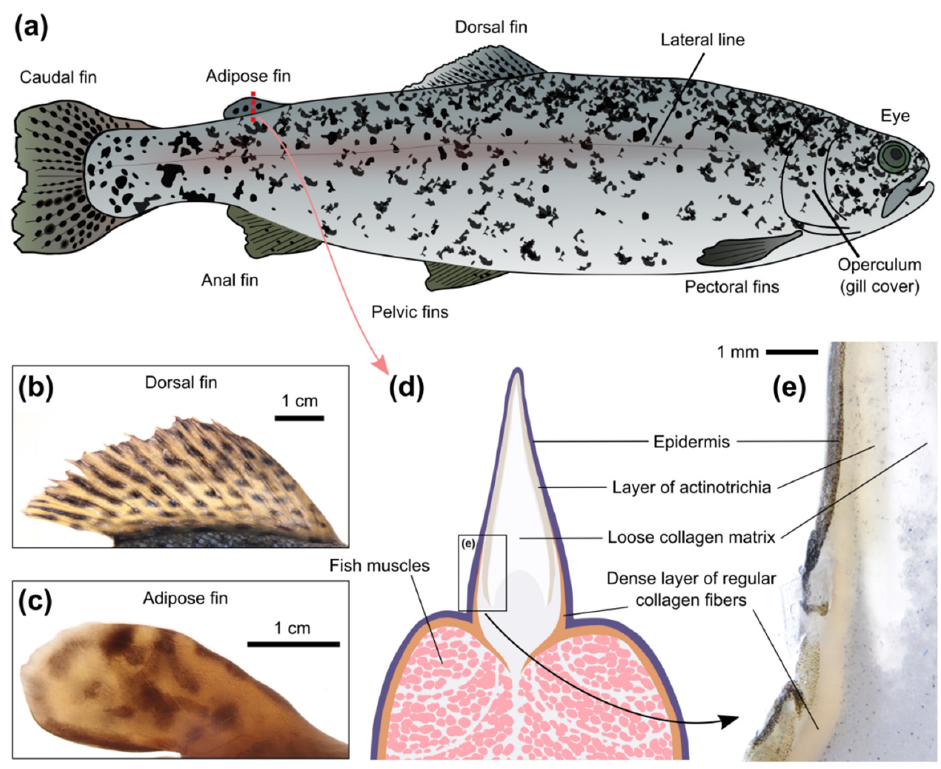
Figure 2. Overview of rainbow trout with focus on the adipose fin. ( a ) General anatomy of the rainbow trout ( Oncorhynchus mykiss ). ( b ) Photo of the dorsal fin of an adult rainbow trout with brightfield illumination. ( c ) Photo of the adipose fin of an adult rainbow trout with brightfield illumination. ( d ) Scheme of the transversal section of the adipose fin and the adjacent muscles. ( e ) A transversal section of the proximal part of the adipose fin. Note the difference in the dermis structures underneath the scaled skin on the back and in the adipose fin.